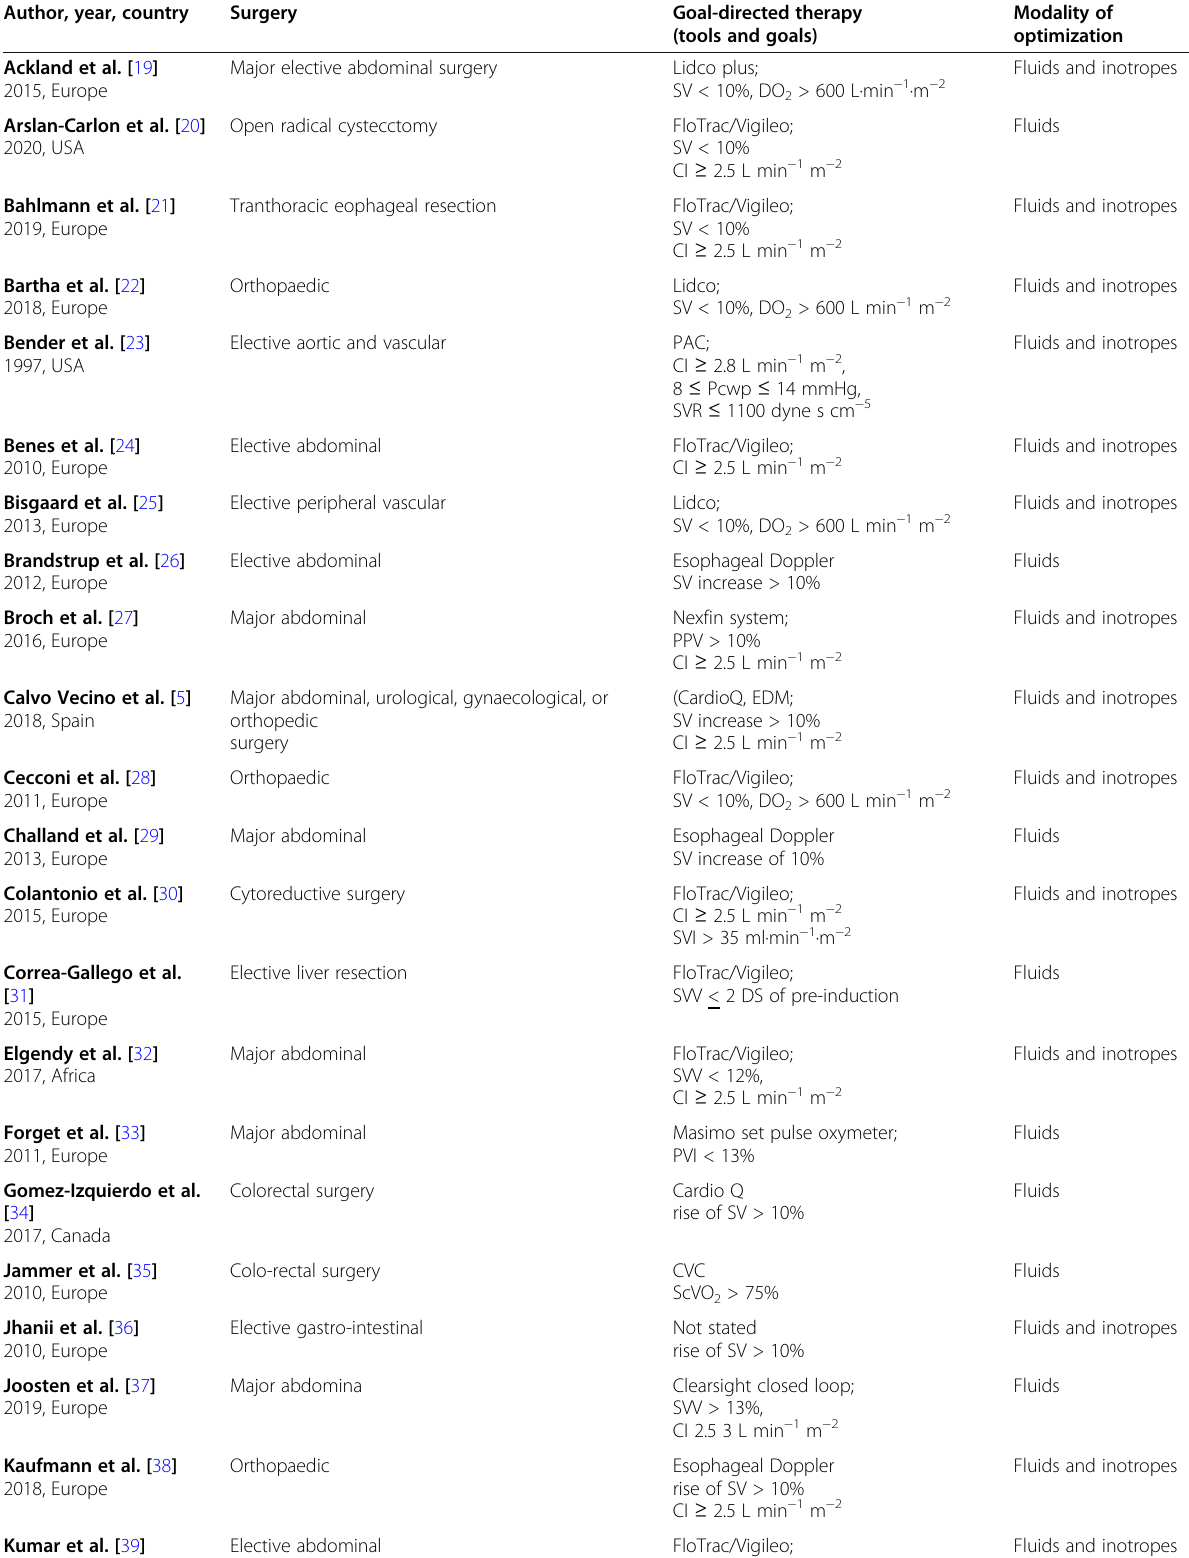
Table 1 Characteristics of included